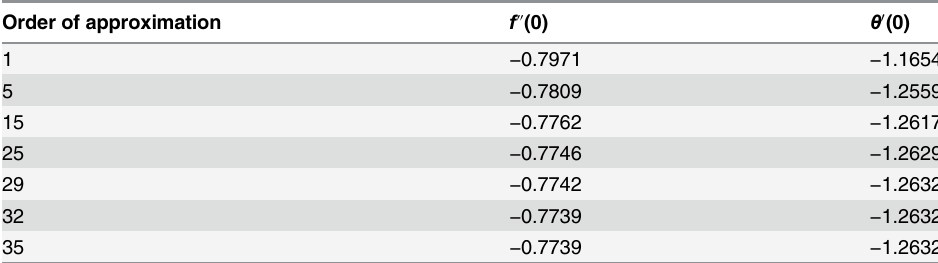
Table 1. Convergence of the series solutions for different order of approximations when λ = 0.3, ε = 0.2, γ = 0.1, Pr = 1, β = 0.2 and n = 2. Order of